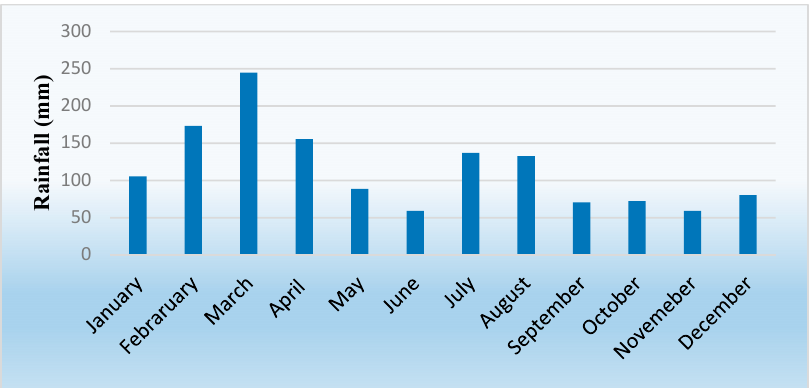
Figure 7. Average monthly precipitation at the Timergara met station.